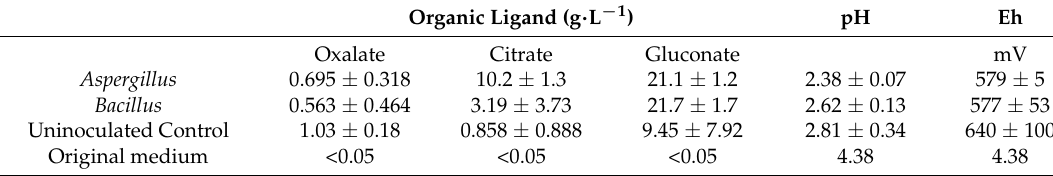
Table 4. Concentration of oxalate, citrate and gluconate and pH and Eh at the end of the bioleaching experiment. The individual organic acid concentrations in the Salt leachates were below the detection limit of 0.1 g · L − 1 . Eh of salt leachates was 584 ± 13 mV. Errors are standard deviation of triplicates.